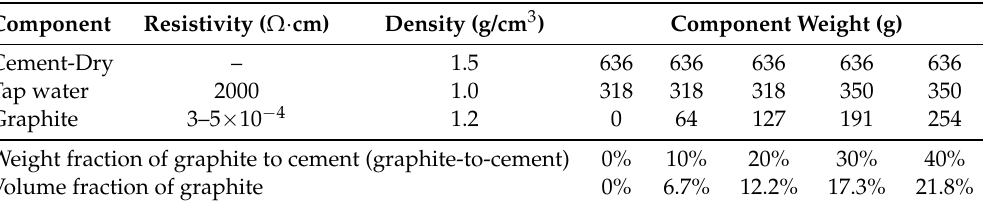
Table 1. Material components for graphite–cement